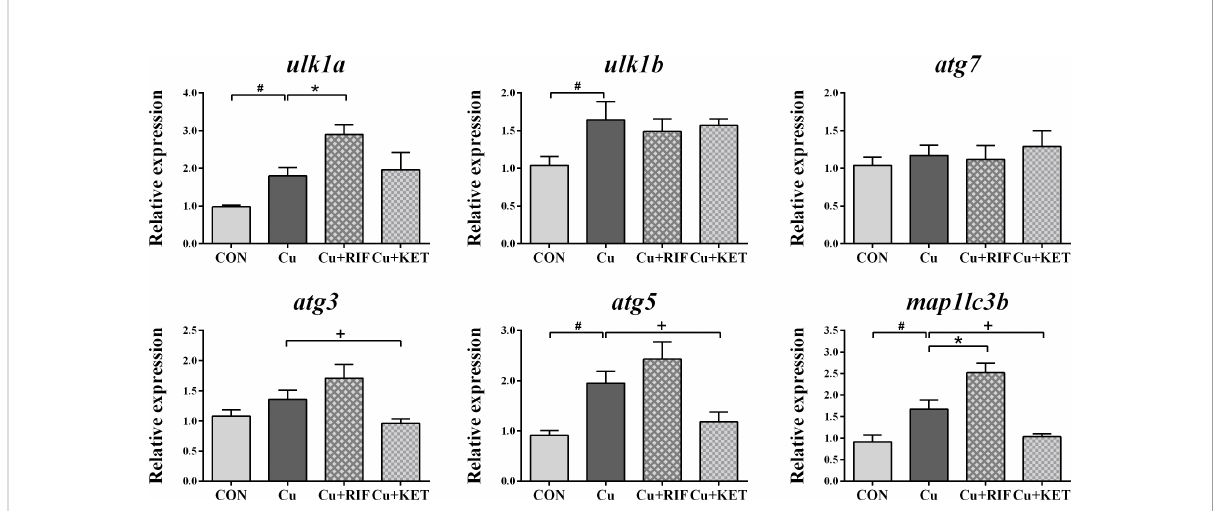
FIGURE 5 Hepatic mRNA levels of genes involved in autophagy in largemouth bass subjected to RIF or KET under Cu exposure (n = 6). Signi fi cant differences between CON and Cu groups, Cu and Cu+RIF groups, as well as Cu and Cu+KET groups were indicated by “ # ” , “ * ” , and “ + ” ( P <